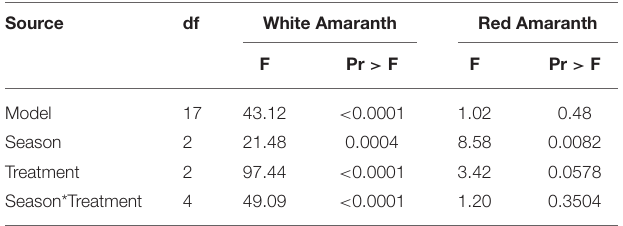
TABLE 4 | Analyses for disease incidence on white amaranth and red amaranth under colored poly-net house, white poly-net house, and open field conditions in Taiwan during 2020–2021.